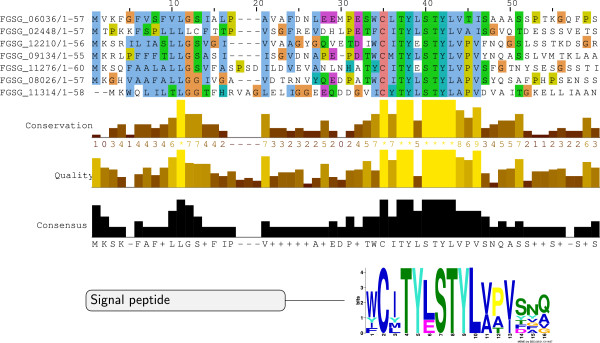
A protein family with a conserved N-terminal [WYF]-C-x-T-Y-x-S-T-Y-L motif in F. graminearum. MEME returns a [WYF]-C-x-T-Y-x-S-T-Y-L motif (e-value 1.2e-028) following the predicted signal peptide cleavage site for seven of the proteins in cluster C8. A MUSCLE alignment of the truncated 7 sequences in cluster C8 is visualized by Jalview.